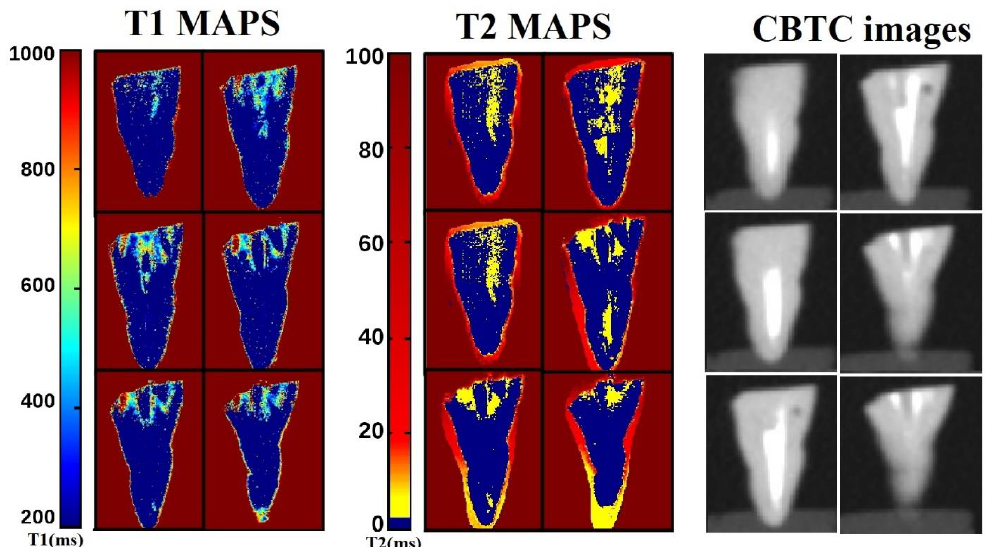
Figure 6. T1, T2 maps and CBCT images obtained from the same tooth slices showing the different and complementary image contrast assessed by mMRI maps and CBCT images. Water is present inside the canal, both in the coronal, middle and apical thirds, showing an incomplete three-dimensional filling and consequently fluid leakage. By considering the T1 and T2 values, in the last apical 3 mm, it is possible to evidence the presence of some inorganic tissue and water (light blue and yellow areas).